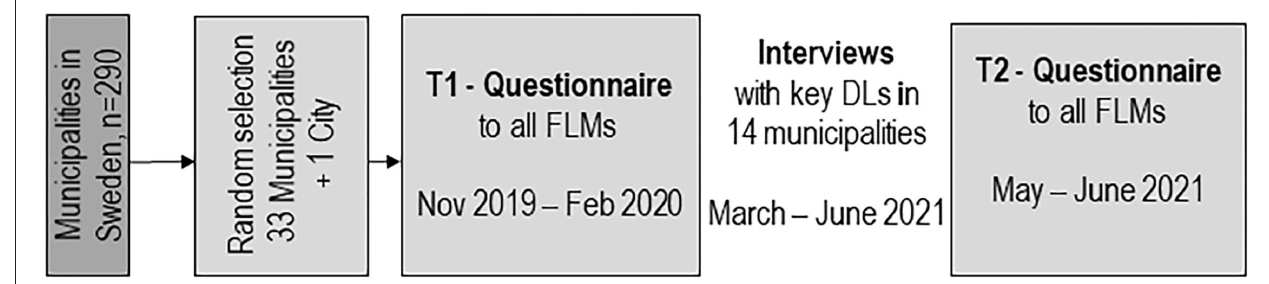
FIGURE 1 | Overview of the data-collection and study-populations.